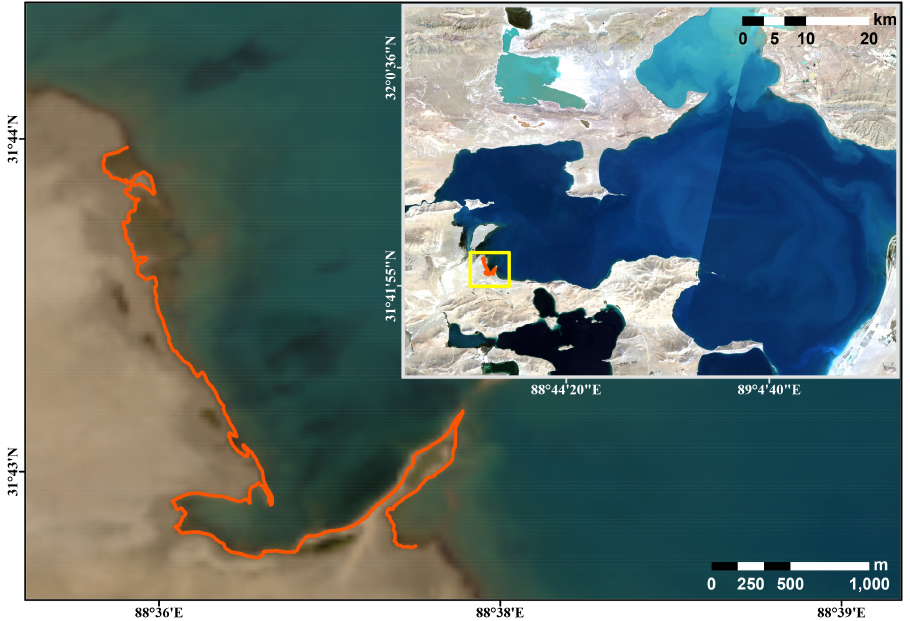
Figure 4. Lake shoreline measured with GPS (orange line) and the measured area (yellow